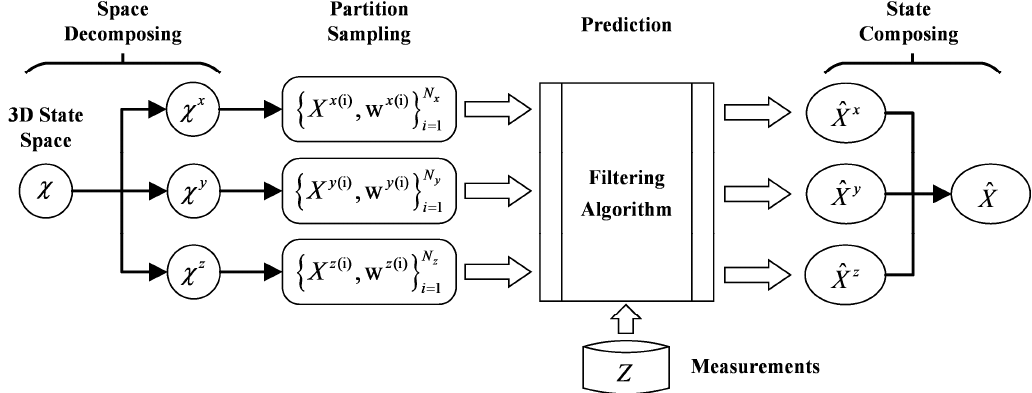
Figure 4. Partitioned sampling structural diagram in three-dimensional motion space.